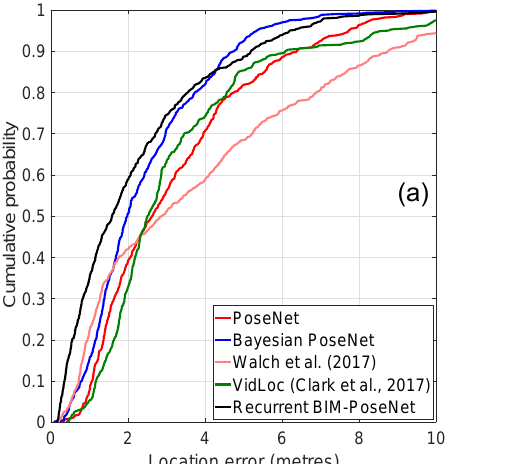
Figure 9. Estimated camera poses by the Recurrent BIM-PoseNet fine-tuned using ( a ) Syn-car, ( b ) Syn-pho-real, ( c ) Syn-pho-real-tex, ( d ) Gradmag-Syn-car, ( e ) Syn-edge. Networks fine-tuned with Syn-Car, Syn-pho-real and Syn-pho-real-tex images were tested with real images, whereas networks fine-tuned with Gradmag-Syn-car and Syn-edge were tested with gradmag of real images.